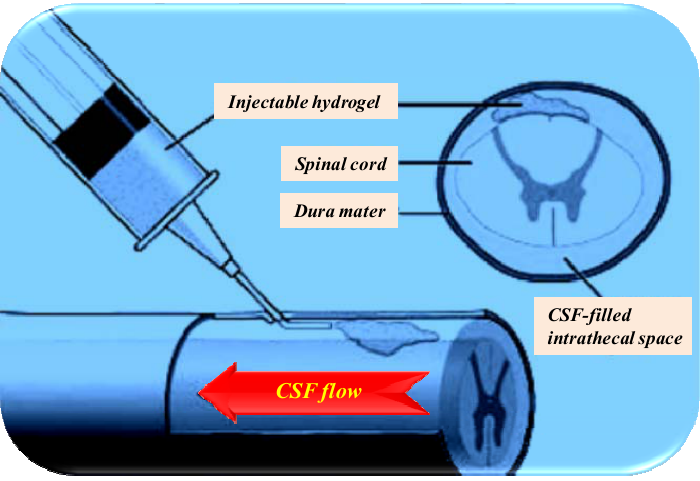
Figure 7. A minimally-invasive intrathecal drug delivery system for spinal cord injury repair (Source: Shoichet lab, McEwen Centre for Regenerative Medicine,